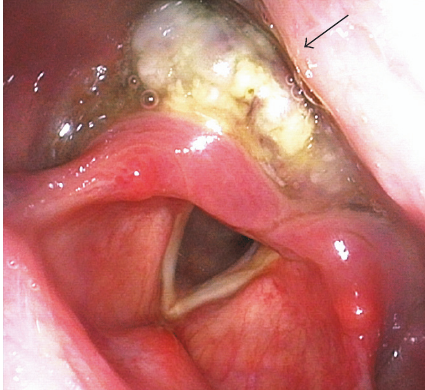
Figure 3: Fiberscopic view of the hypopharynx filled with a large soft tissue mass with necrotic appearance